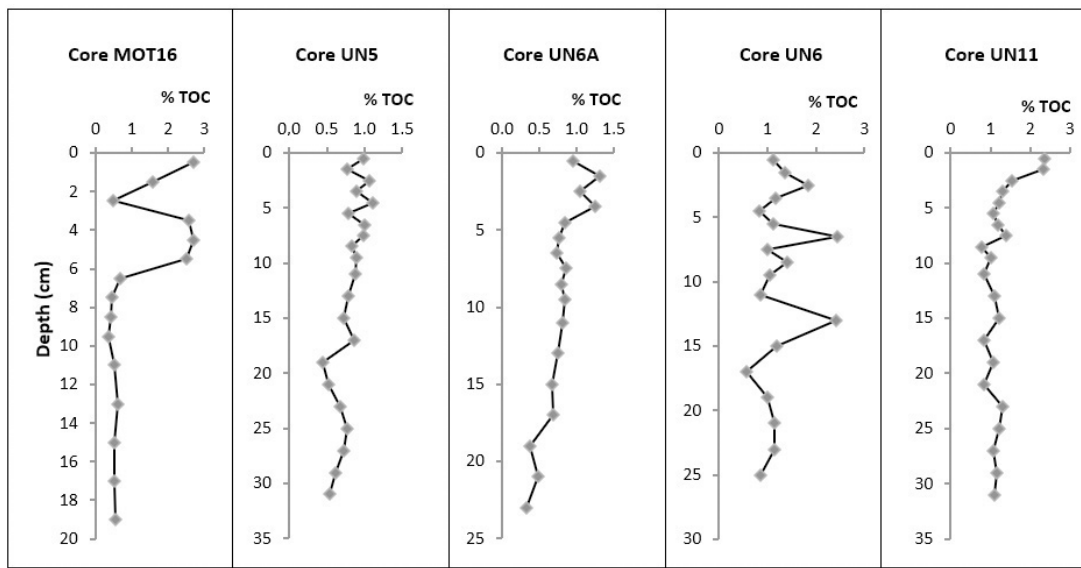
Figure 2. Vertical distribution of %TOC at selected cores (MOT16 profile depicts fine-sediment ( < 63µm) TOC content). Table 3. Concentrations of metals (in mgkg − 1 ) and organic and inorganic carbon content in the two sediment fractions of coarse-grained cores (MOT13A, MOT16,